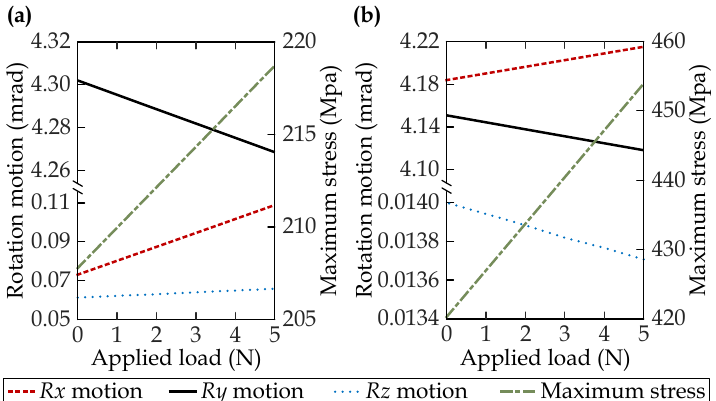
Figure 7. Static performance results with loads. ( a ) Rotation motion and maximum stress in y -axis actuation with loads. ( b ) Rotation motion and maximum stress in x and y -axis actuation.